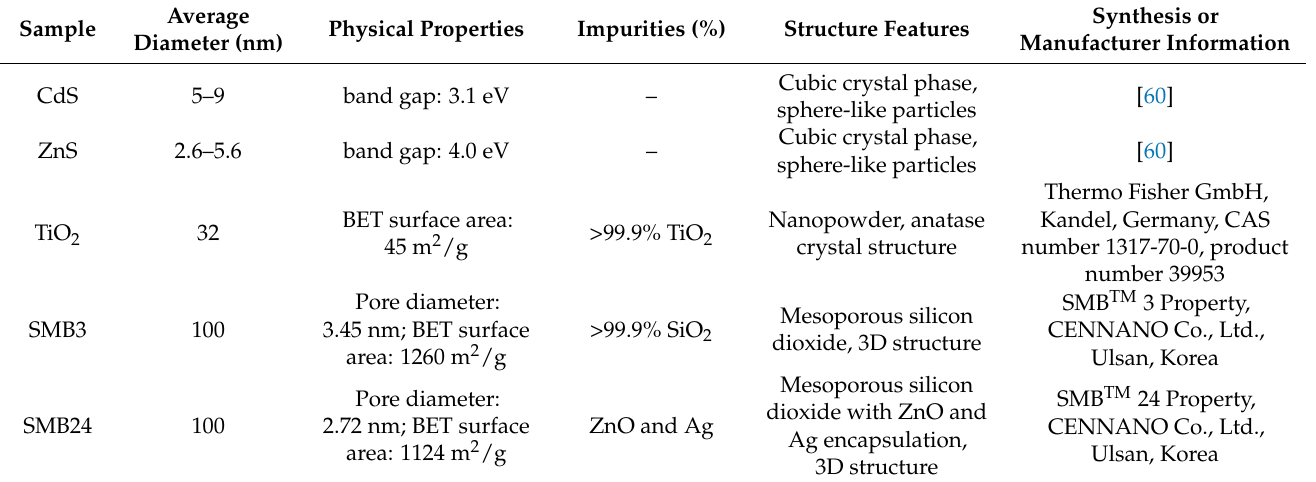
Table 4. Characteristics of the used NPs.